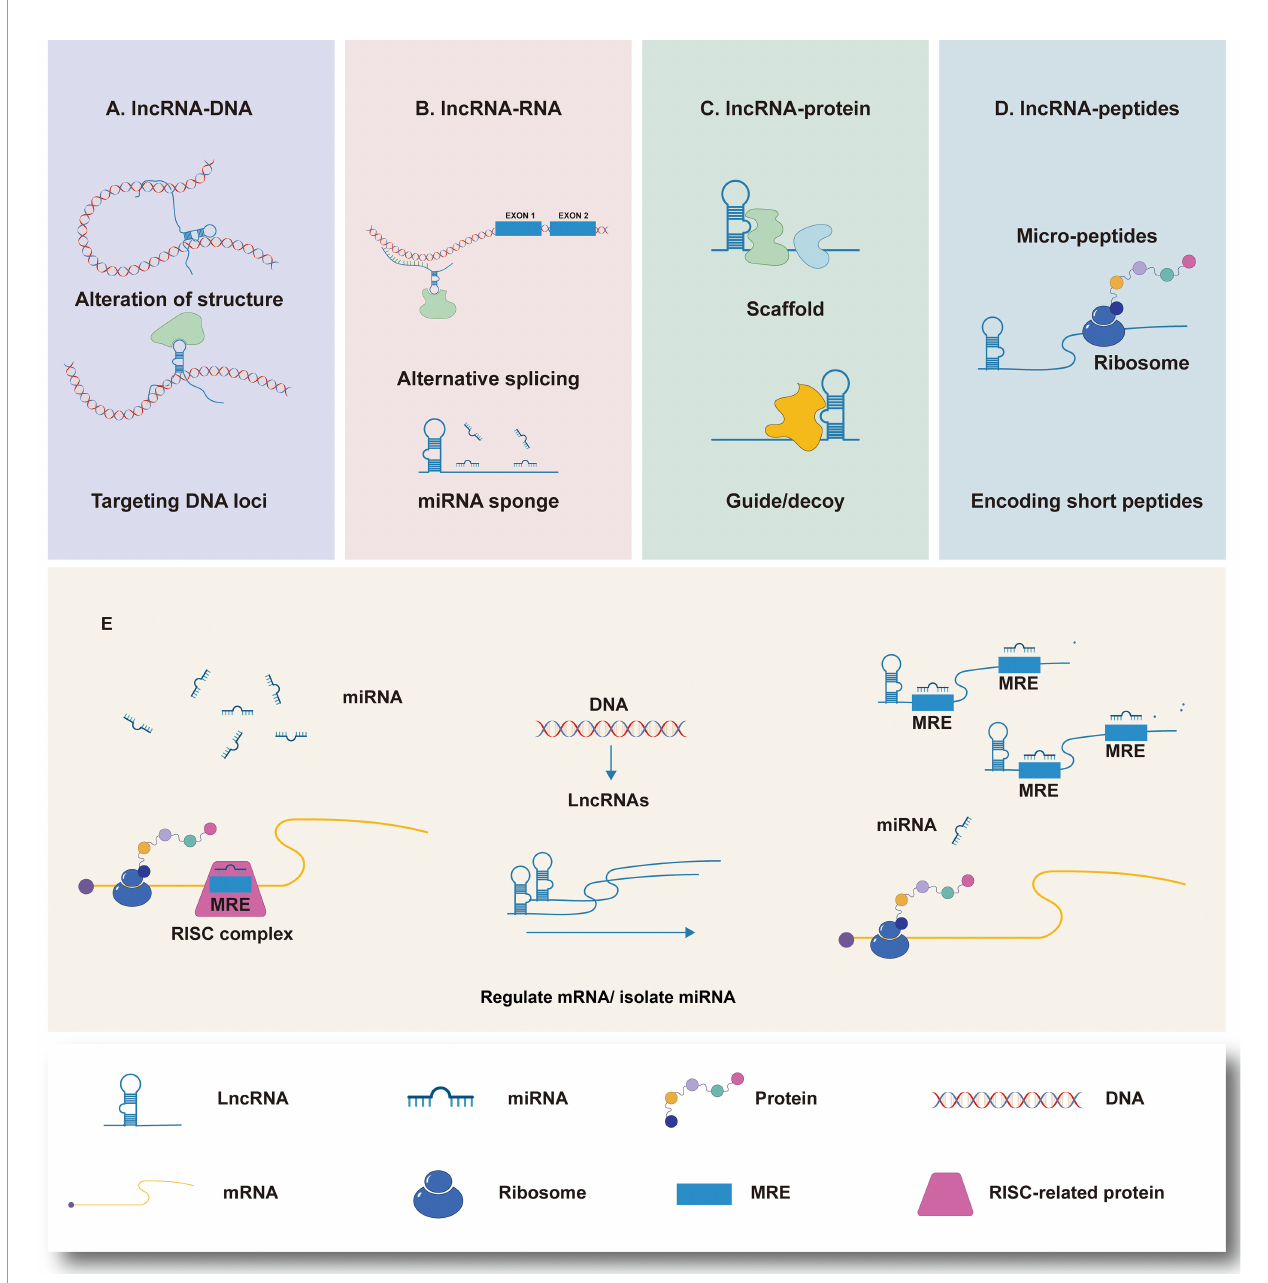
FIGURE 1 | LncRNAs interactionsandfunctions, andthe mechanism of lncRNAs acting as molecular sponge. (A) LncRNAs regulategene expression by affecting local chromatin structure orrecruiting regulatory proteins to speci fi c loci. (B) LncRNAs facilitateRNA inhibition anddegradation through interacting with mRNA andmiRNA to control splicing or actingas a ceRNA ofmiRNA. (C) LncRNAs can serve as molecular scaffolds, guides, or decoys for regulatory proteinsto regulate protein. (D) A part of lncRNAs are able to encodeshort peptides. (E) MiRNAs are capable ofdirectlybindingto the matched regionsof mRNAs byspeci fi c identi fi cation in a base-pairing manner, andthusinducing mRNA degradation at the post-transcriptional level byforming RNA-induced silencing complex (RISC) with related proteins such as Argonaute 2 (AGO2). LncRNAs ownthe miRNA response elements (MREs)which have complementary miRNA binding sites that can competitively bindto miRNAs. Therefore, lncRNAs are able to exertits biological functionsby regulating the expression of mRNAs orsequestering corresponding miRNA